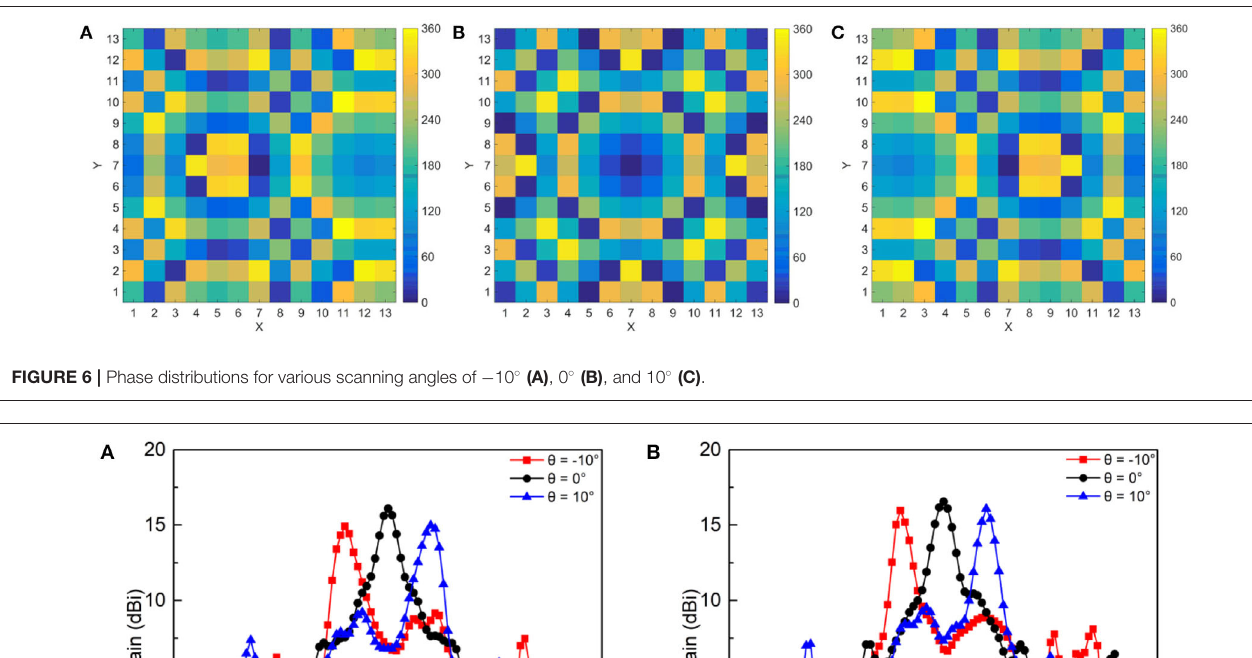
10 ◦ (A) , 0 ◦ (B) , and 10 ◦ (C) . −